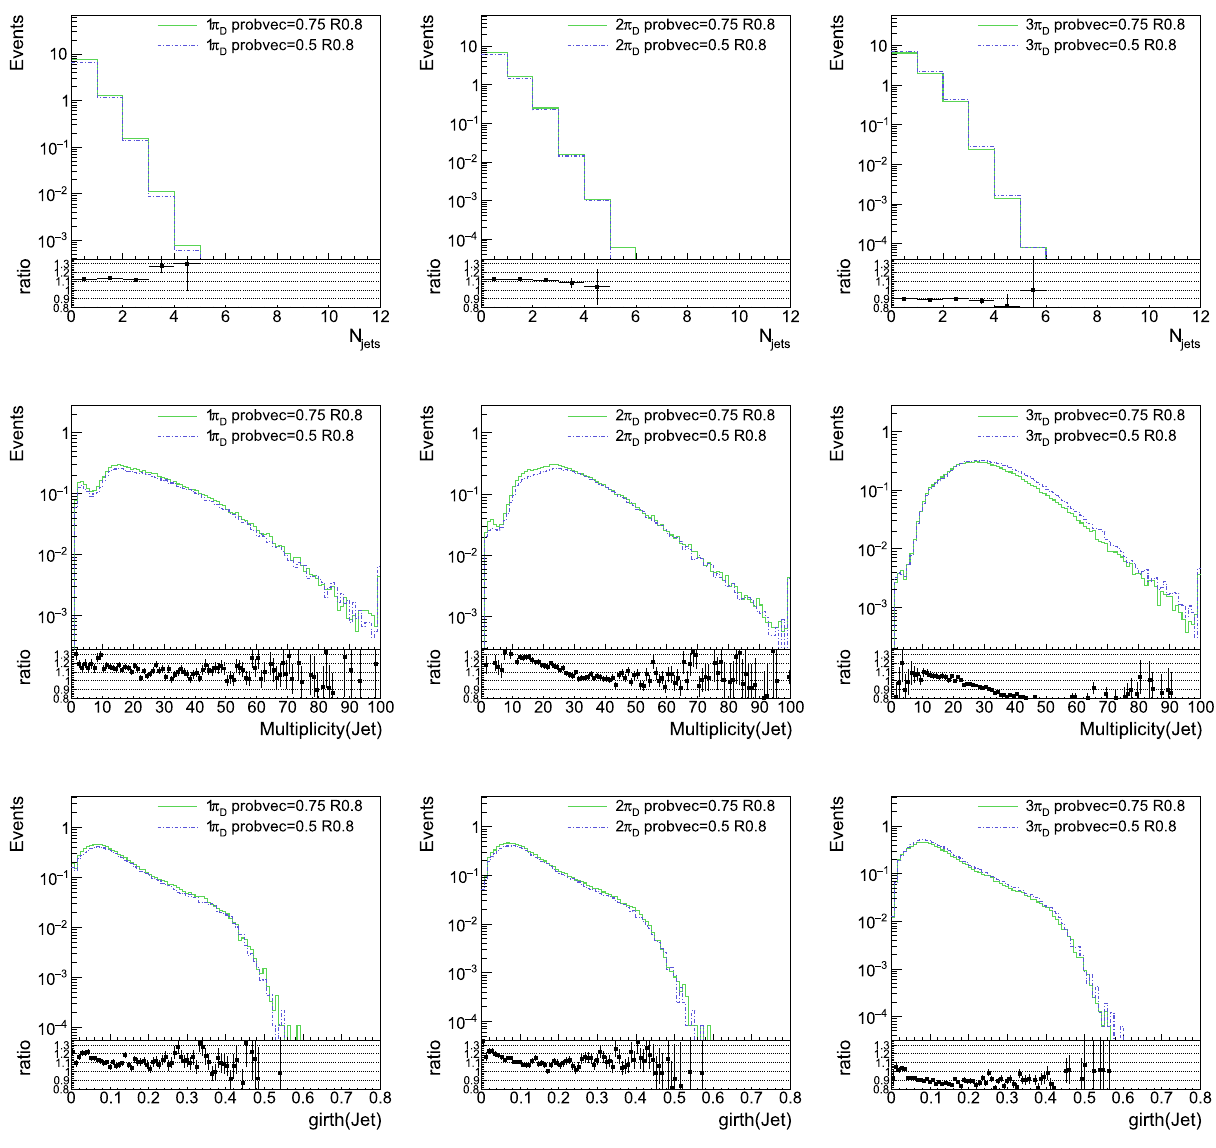
Fig. 46 Comparison of reco-level variables between probVector=0.5 and probVector=0.75 for different number of unstable diagonal dark pions. The first row shows the number of reconstructed jets, the second row shows the constituent multiplicity of